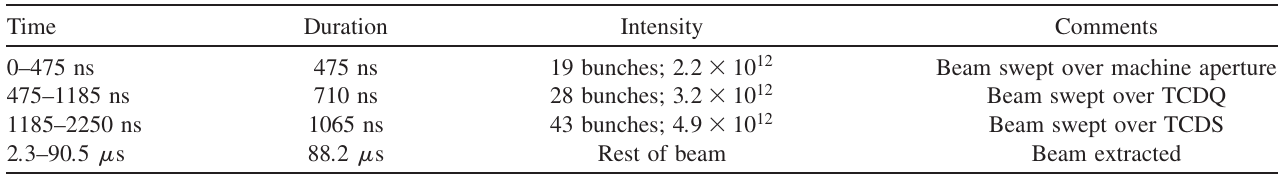
TABLE II. Sweep parameters for asynchronous dumps under nominal conditions.